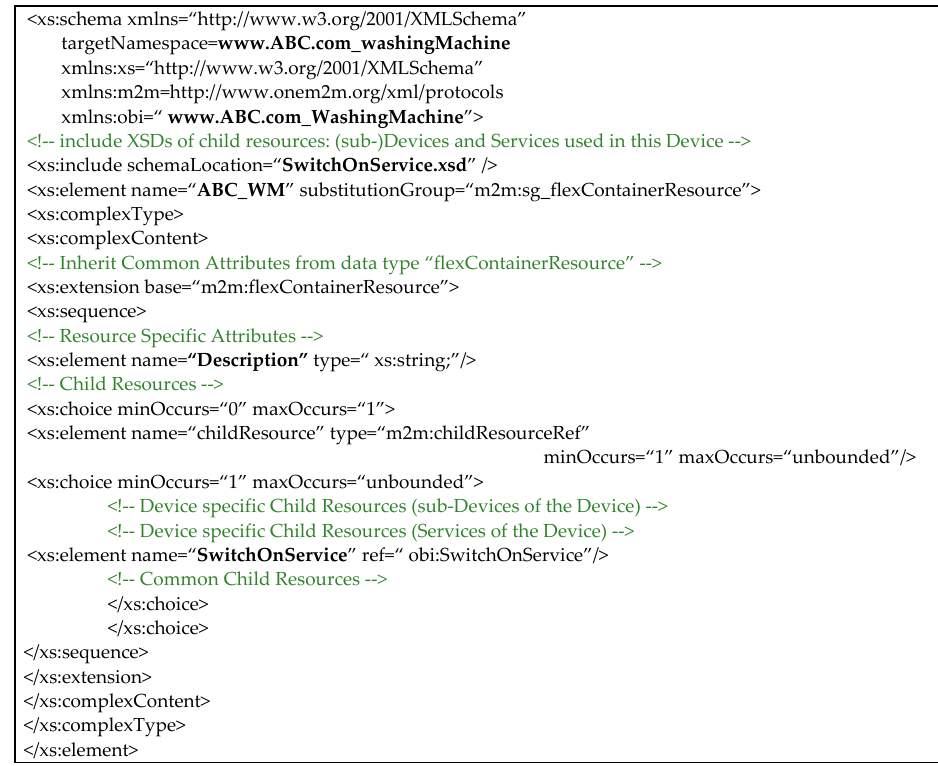
Figure 10. XSD file representing the ABC: ABC_WM class as a <flexContainer> oneM2M resource. According to the common ontology shown by Figure 9 and on the XSD files relevant the ABC:ABC_WM and ABC:SwitchOnService, Figure 11 shows how the CSE could be filled by the IPE in order to represent in the oneM2M CSE, the interworked device and the relevant Service belonging to the ABX washing machine ontology.